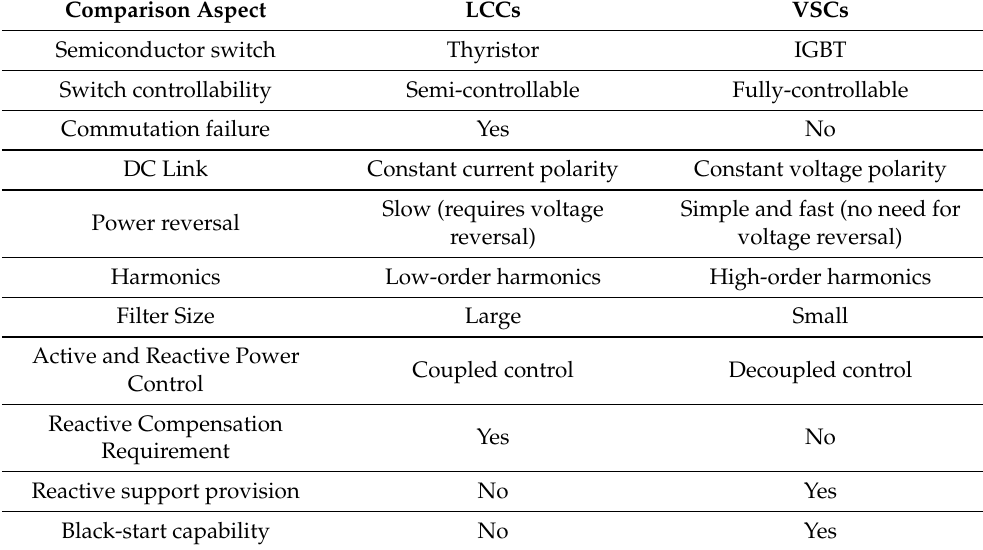
Table 1. Comparison between LCCs and VSCs.